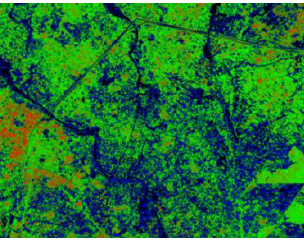
Fig. 12 Spectral angle mapper classified PALSAR